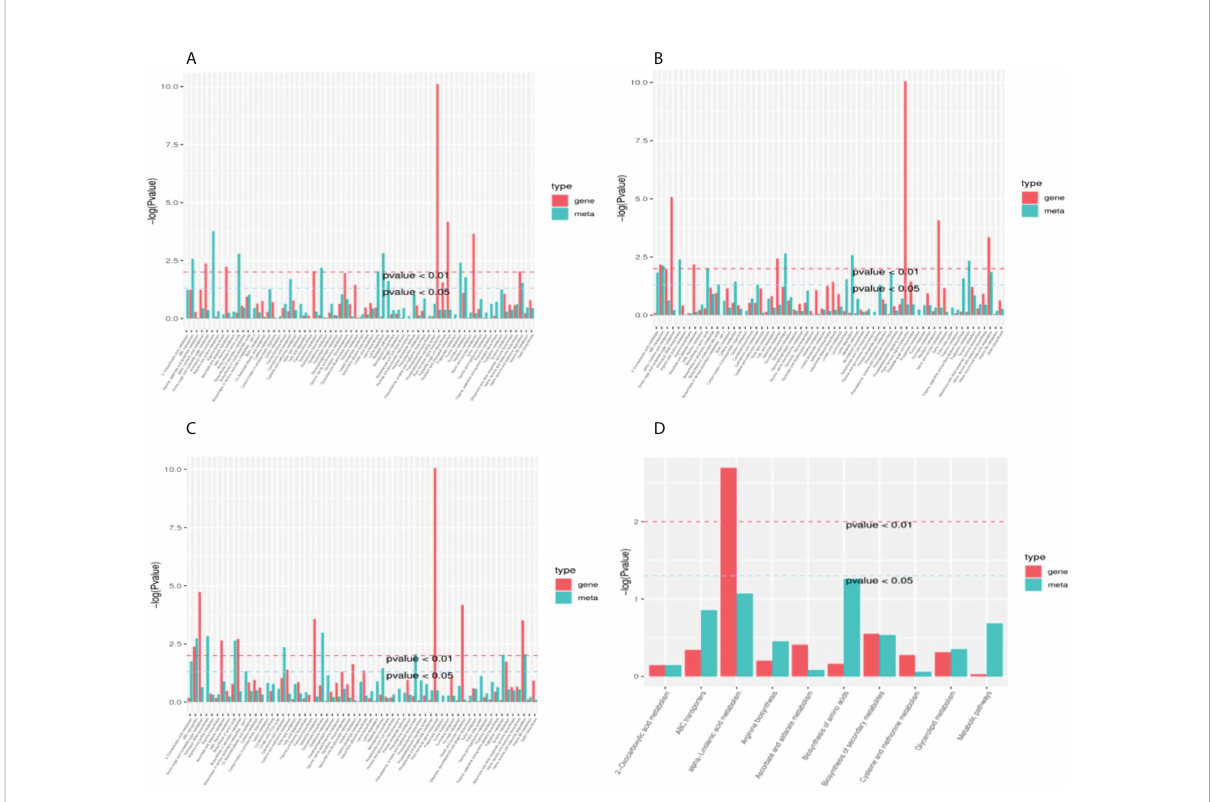
FIGURE 4 KEGG enrichment analysis pvalue histogram of DEGs and DAMs. (A) , CK vs T1; (B) , CK vs T2; (C) , CK vs T3; (D) , T1 vs T3. The abscissa represents metabolic pathways, and the ordinate represents the enriched pvalue of DEGs (red) and DAMs (green), which is represented by -log (Pvalue). The higher the ordinate, the stronger the enrichment